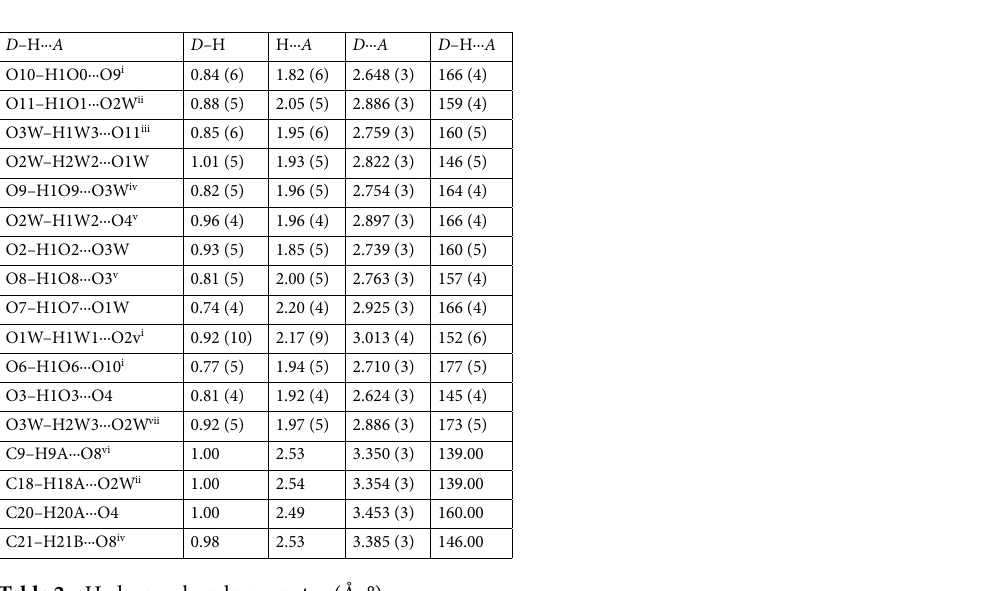
Table 2. Hydrogen-bonds geometry (Å,